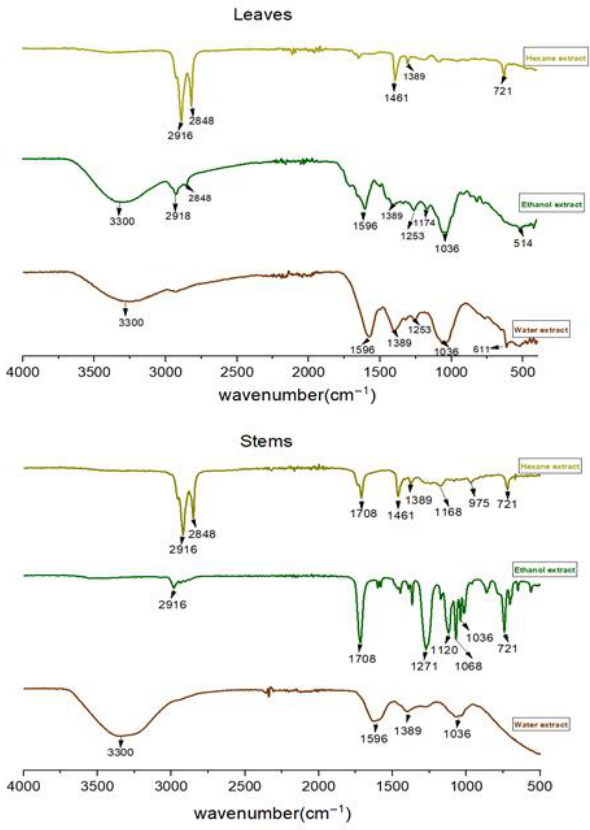
Figure 1. Fourier-Transform Infrared (FTIR) spectra of hexane, ethanol, and water extracts for leaves and stems. Table 2. Assignment of the absorption bands of the Fourier-Transform Infrared (FTIR) spectra of the extracts.